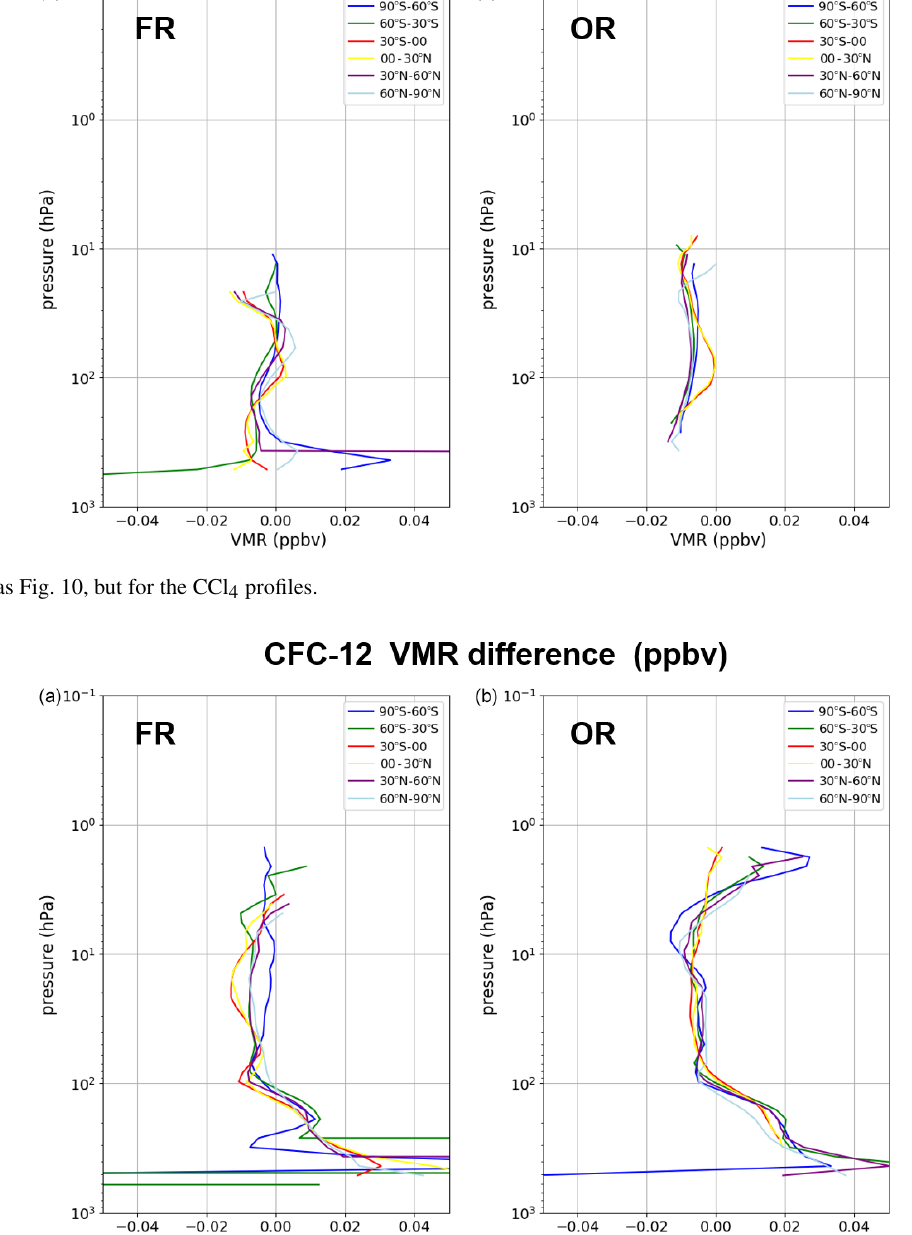
Figure 15. Same as Fig. 10, but for the CFC-12